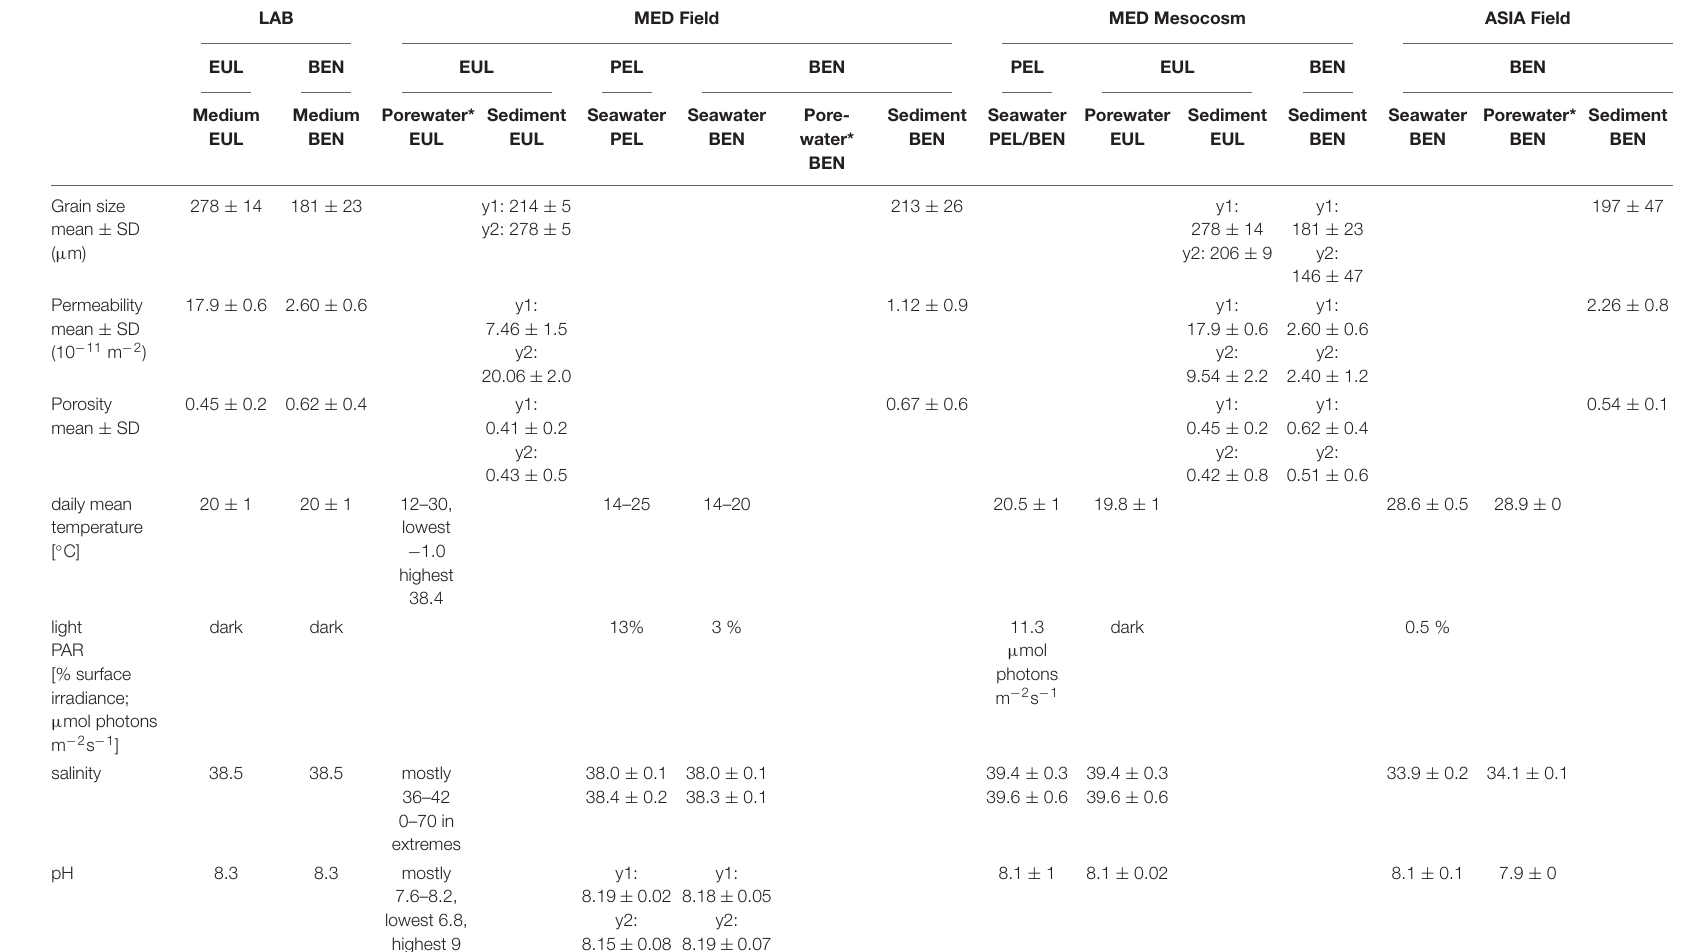
TABLE 2 | Experimental conditions: Properties of the water and sediments from the lab, field, and mesocosm